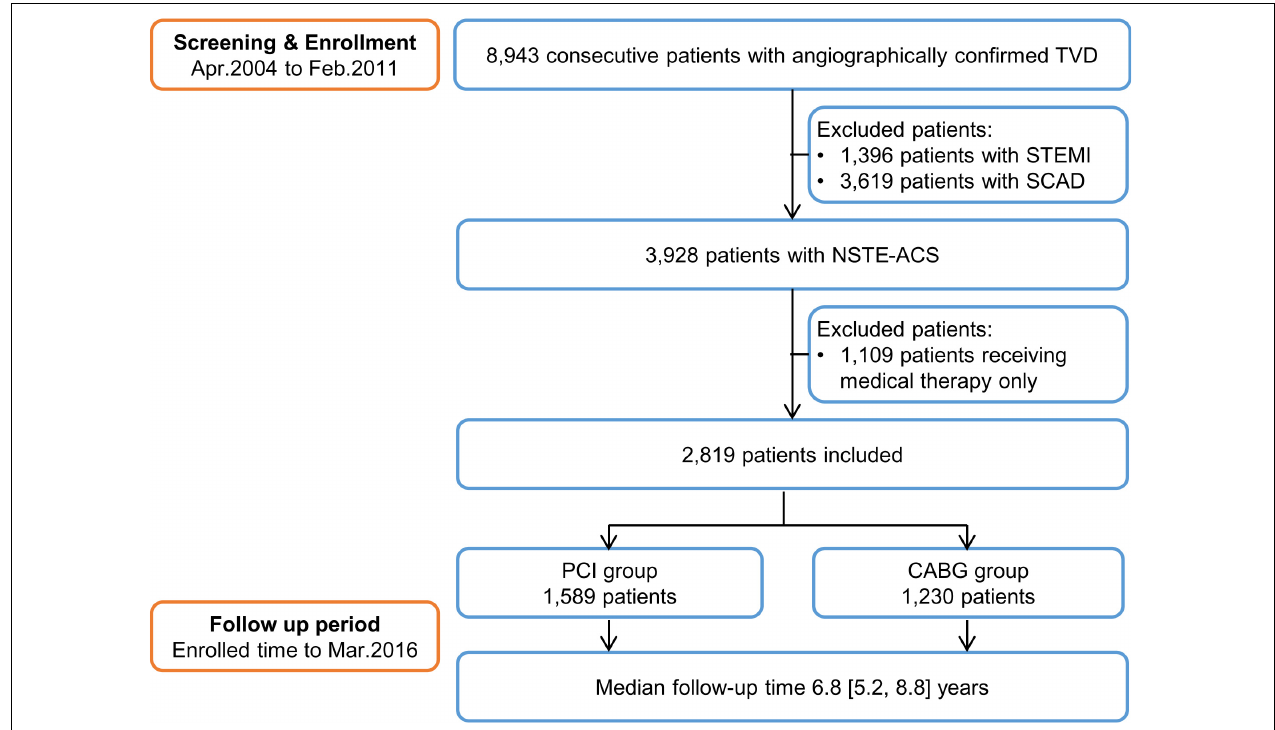
FIGURE 1 | The study flow chart. TVD, three-vessel disease; STEMI, ST-segment elevation myocardial infarction; SCAD, stable coronary artery disease; NSTE-ACS, non-ST-segment elevation acute coronary syndrome; PCI, percutaneous coronary intervention; and CABG, coronary artery bypass grafting.